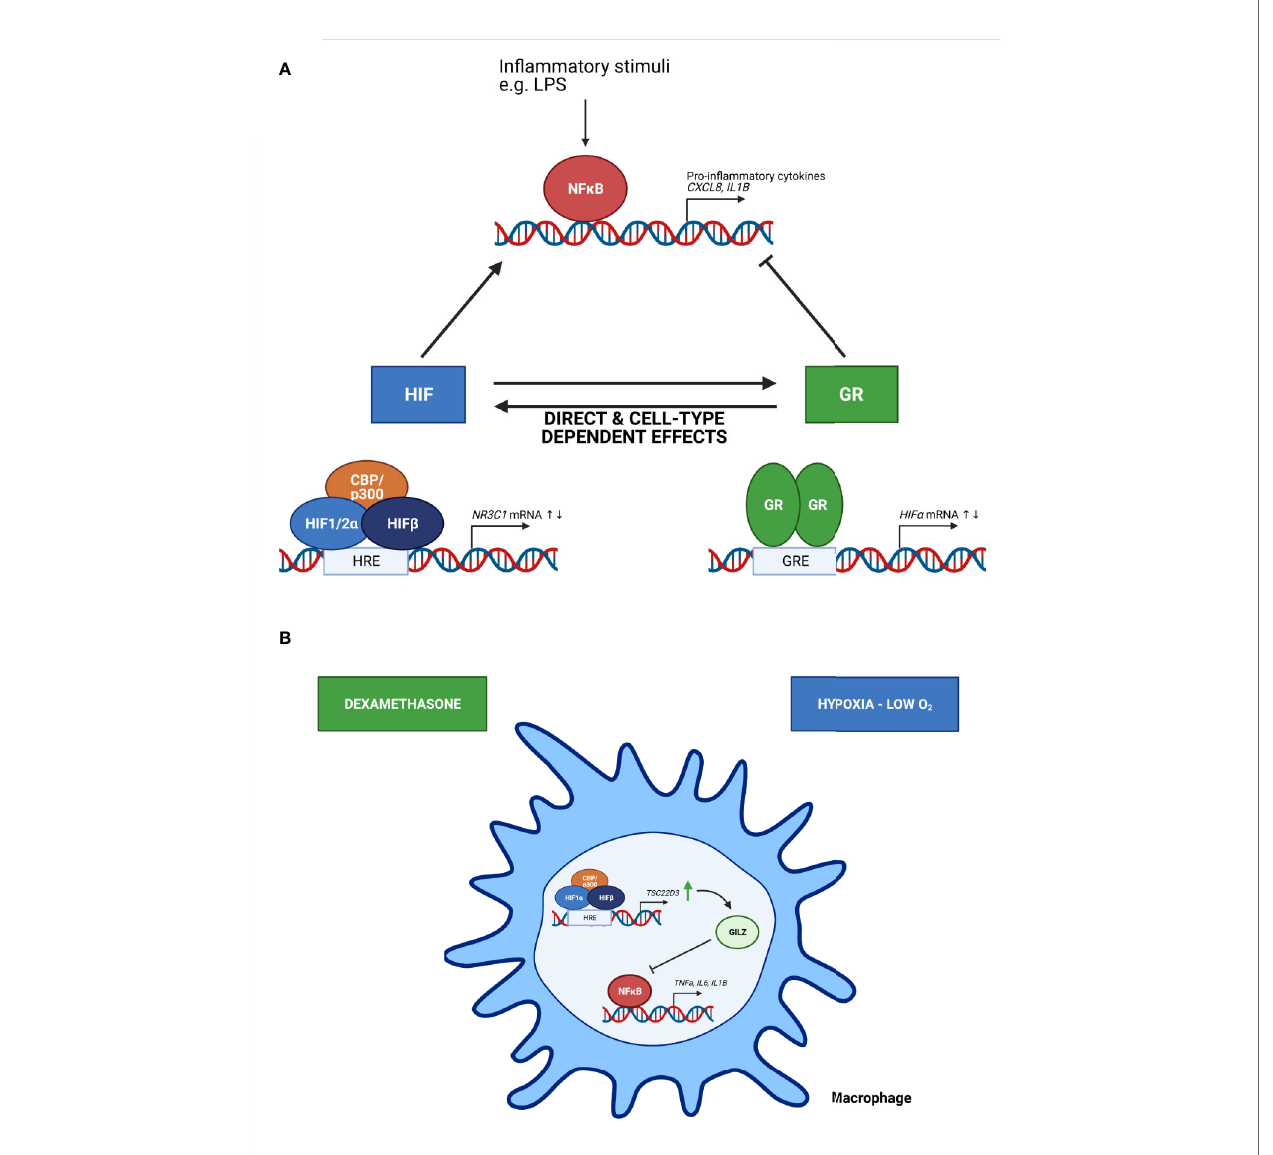
FIGURE 4 | The crosstalk between HIF and GR and its effect on NF- k B activity (A) and the effect of oxygen availability on immune cells (B) . (A) Based on in vitro studies, HIF and GR have direct and cell-type dependent effects on each other, thereby increasing or repressing the transcription of HIF mRNA and N3RC1 mRNA genes. In fl ammatory stimuli like lipopolysaccharide (LPS) induce NF- k B mediated transcription of genes encoding pro-in fl ammatory cytokines. HIF is known to stimulate this NF- k B mediated gene transcription, while GR will repress this. (B) Upon hypoxic conditions, the expression of GC-induced leucine zipper (GILZ) encoded by the TSC22D3 gene is upregulated, thereby inhibiting the expression of pro-in fl ammatory cytokines mediated by NF- k B. When macrophages are pre- treated with dexamethasone, a synthetic GC, the effects are ampli fi ed. Figures created with